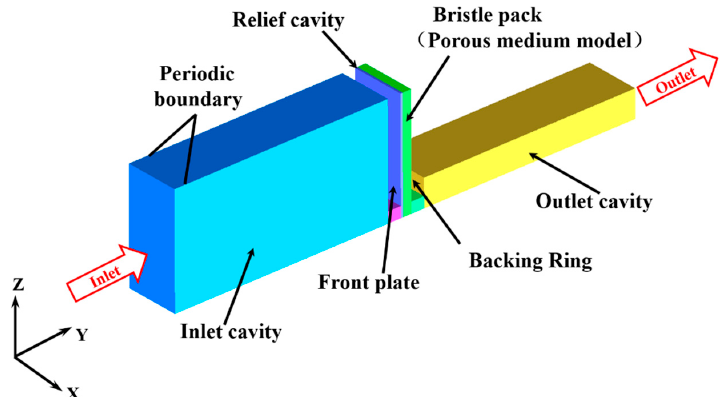
Figure 3. Computational domain.